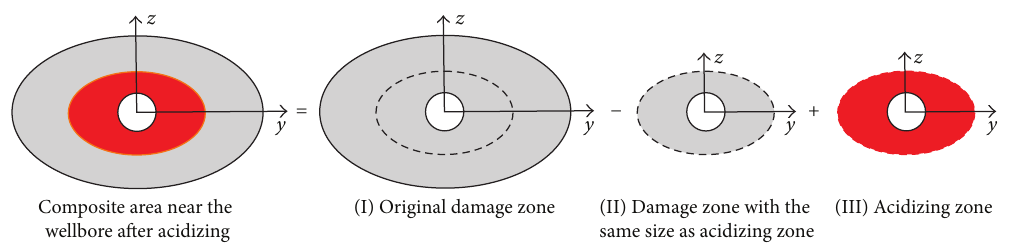
Figure 1: Division of elliptic composite